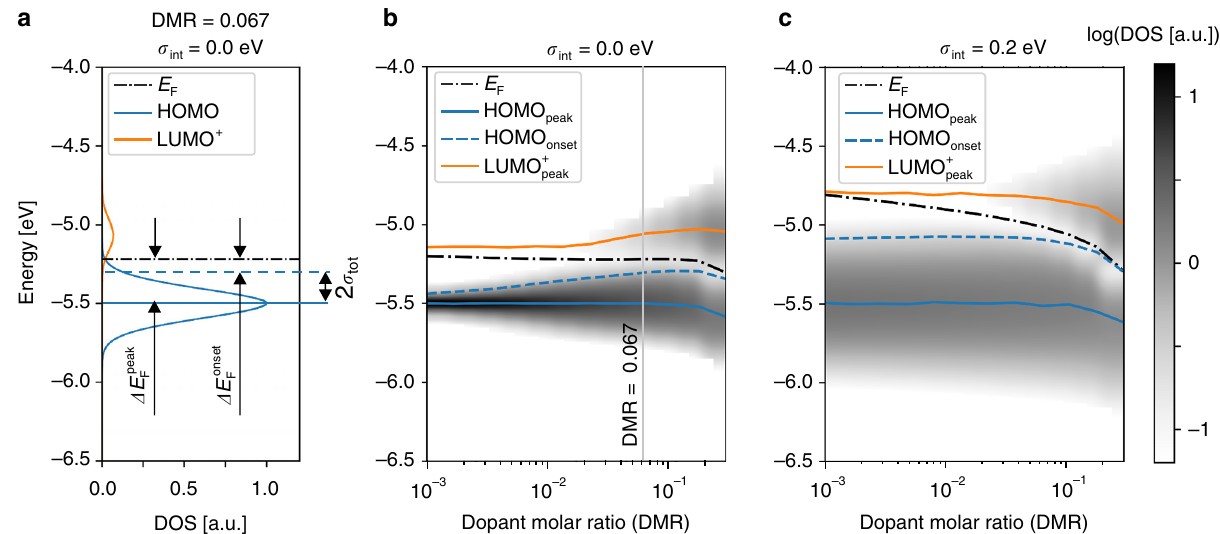
Fig. 3 Shift of the Fermi level and frontier orbitals energies upon doping. a The de fi nition of the Fermi level shift with respect to the peak and the onset of the HOMO, Δ E peak and Δ E onset , respectively shown in the material with DMR = 0.067 and zero intrinsic disorder ( σ int = 0). The total material disorder is F F denoted by σ tot . b and c , Evolution of the density of states ( DOS) upon doping (the grayscale shows the DOS in logarithmic scale) for organic materials with zero ( σ int = 0.0 eV) and high ( σ int = 0.2 eV) intrinsic disorder, respectively. The peaks of the HOMO and LUMO + distributions are denoted as , respectively. HOMO onset stands for the onset of the HOMO distribution, and E F is the Fermi level. Panel a is a cut of Panel b at HOMO peak and LUMO þ peak DMR = 0.067 as shown with a grey line